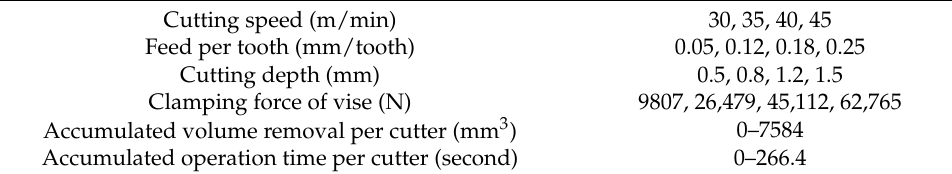
Table 2. Cutting parameters, accumulated volume removal and operation time.